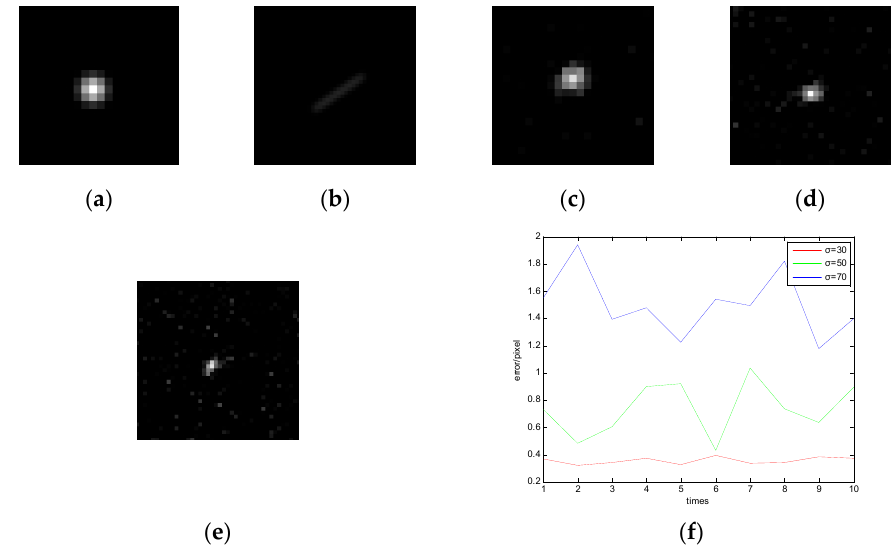
Figure 4. Effect of noise on centroid extraction after restoration. ( a ) Original image; ( b ) star image under dynamic conditions; ( c ) result of Richardson Lucy (RL) restoration with variance of 30; ( d ) result of RL restoration with variance of 50; ( e ) result of RL restoration with variance of 70; ( f ) error curve of the X axis.